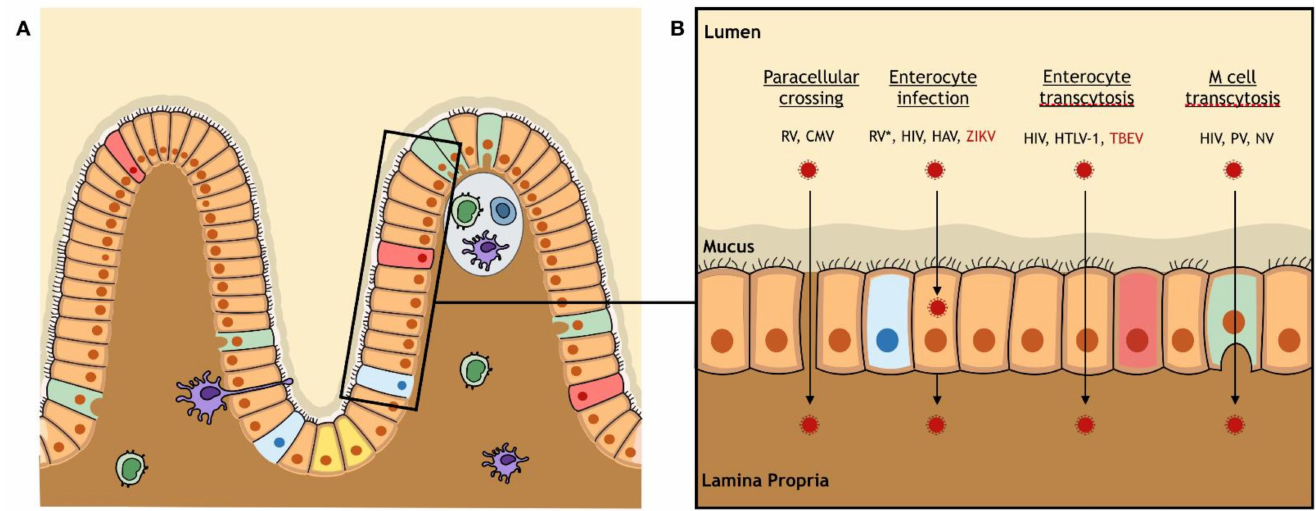
Figure 5. The intestinal barrier: anatomy and viral crossing. ( A ) The intestinal barrier is a monostratified epithelium composed of different cell types that all differentiate from pluripotent stem cells (yellow) located at the bottom of the crypts: enterocytes (orange), goblet cells (pink), Paneth cells (blue), and microfold cells (M cells) (green). Underlying the epithelium, the gut-associated lymphoid tissue is composed of free and anchored immune cells. Over the lymphoid follicles, the follicle-associated epithelium is enriched by M cells. ( B ) The intestinal barrier can be crossed by paracellular crossing by Rotavirus (RV), by enterocyte infection by RV (*: after paracellular crossing), Human immunodeficiency virus (HIV), Hepatitis A virus (HAV), and Zika virus (ZIKV), by transcytosis through enterocytes by HIV, type 1 Human T-cell lymphotropic virus (HTLV-1), and Tick-borne encephalitis virus (TBEV), or by transcytosis through M cells by HIV, Poliovirus (PV), and Norovirus (NV). The only arboviruses (red) that were reported to cross the intestinal barrier are TBEV and